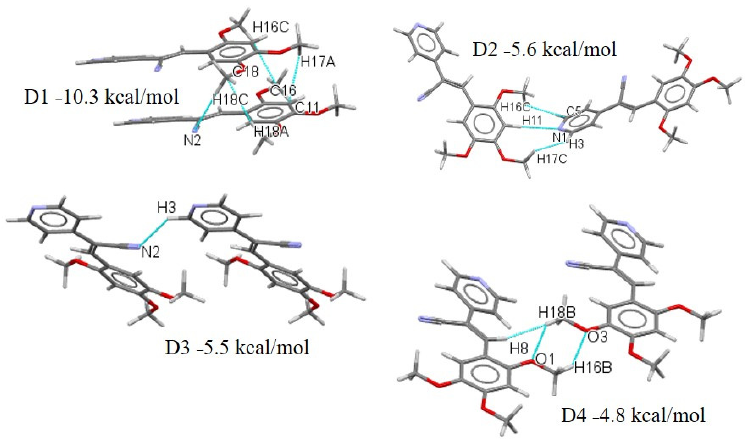
Figure 20. Different dimers (D1–D4) with interactions in the V crystal structure with respective interaction energies.